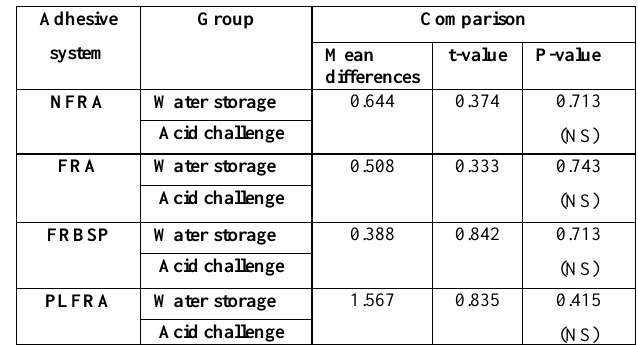
Table 5: Comparison of the effect of ageing media on the mean SBS of the four test adhesive systems.